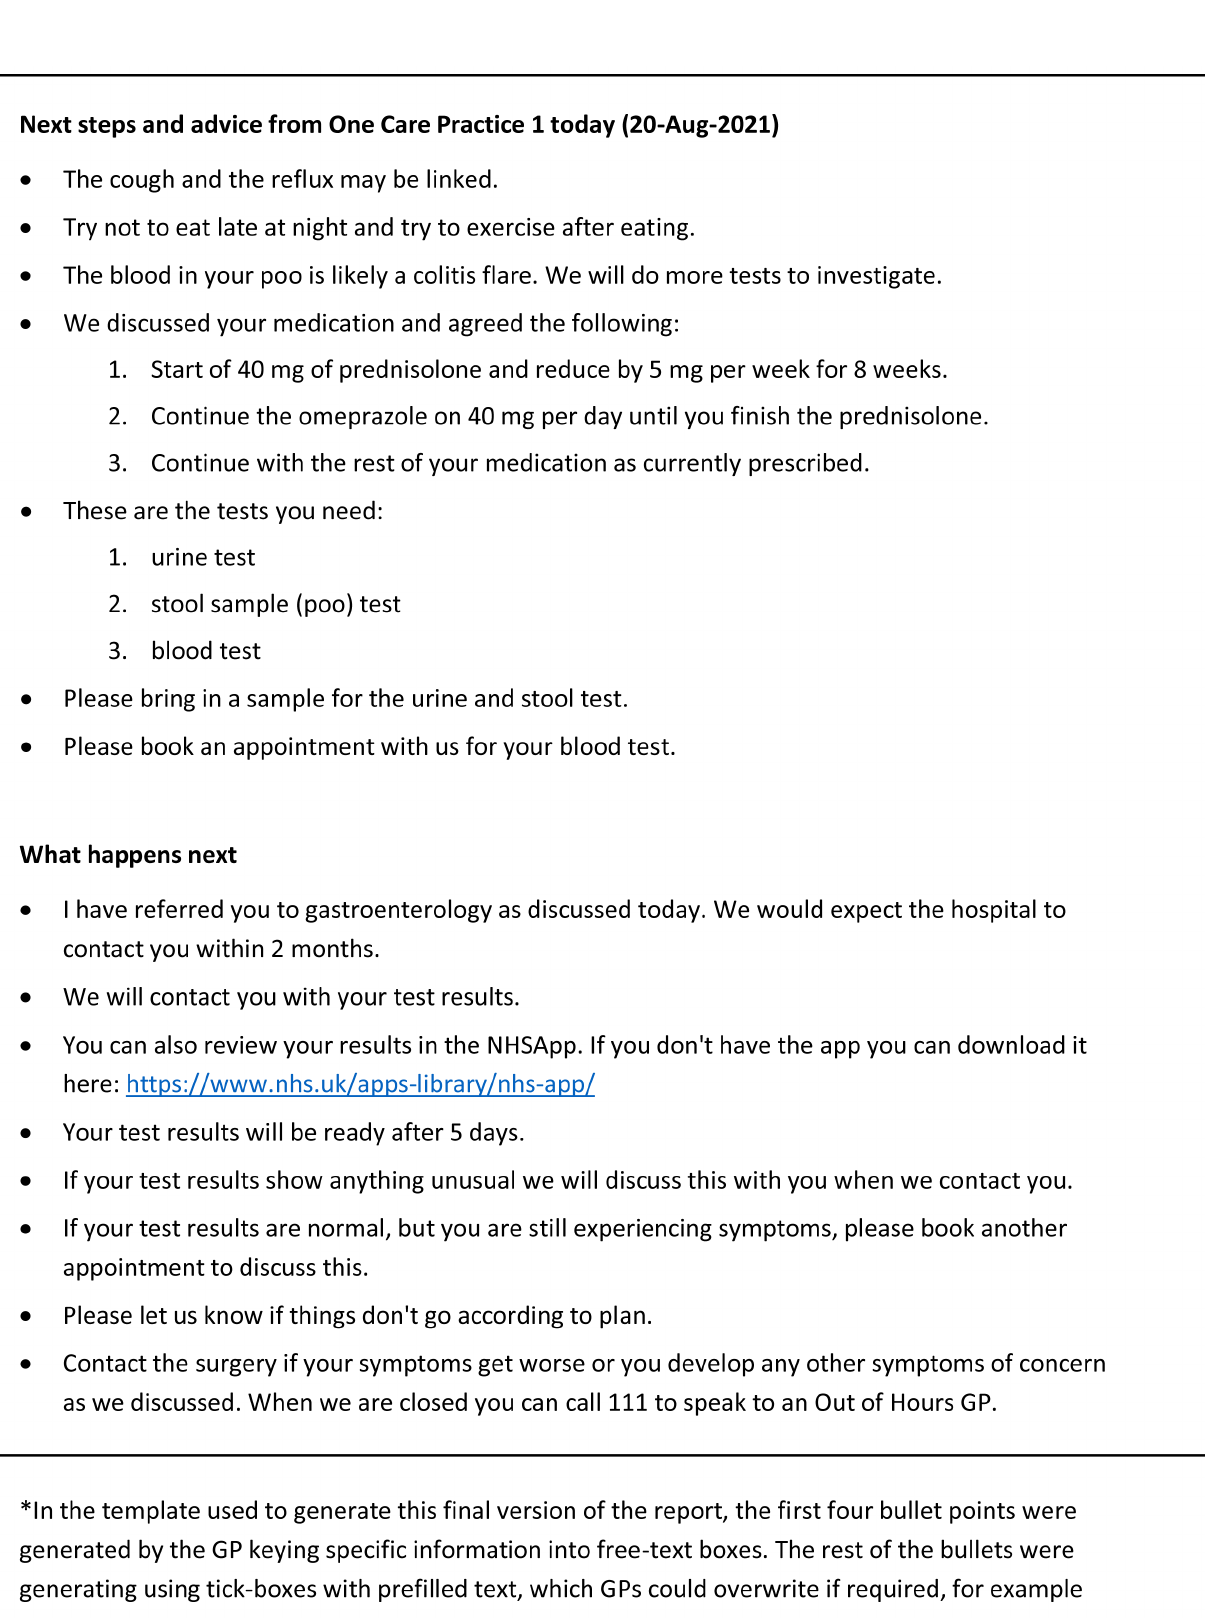
Figure 5. Consultation summary report: Final version (end of intervention development)